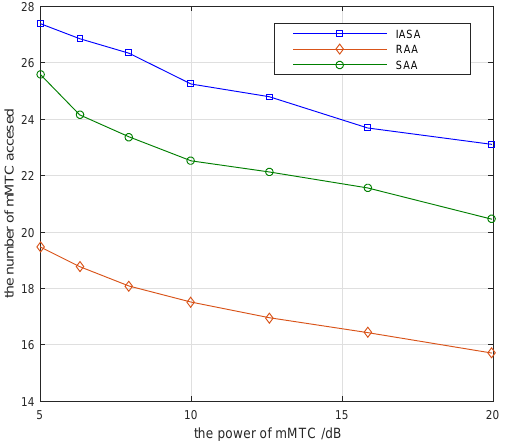
Figure 5. Number of mMTC pairs accessed versus different mMTC device transmit powers.